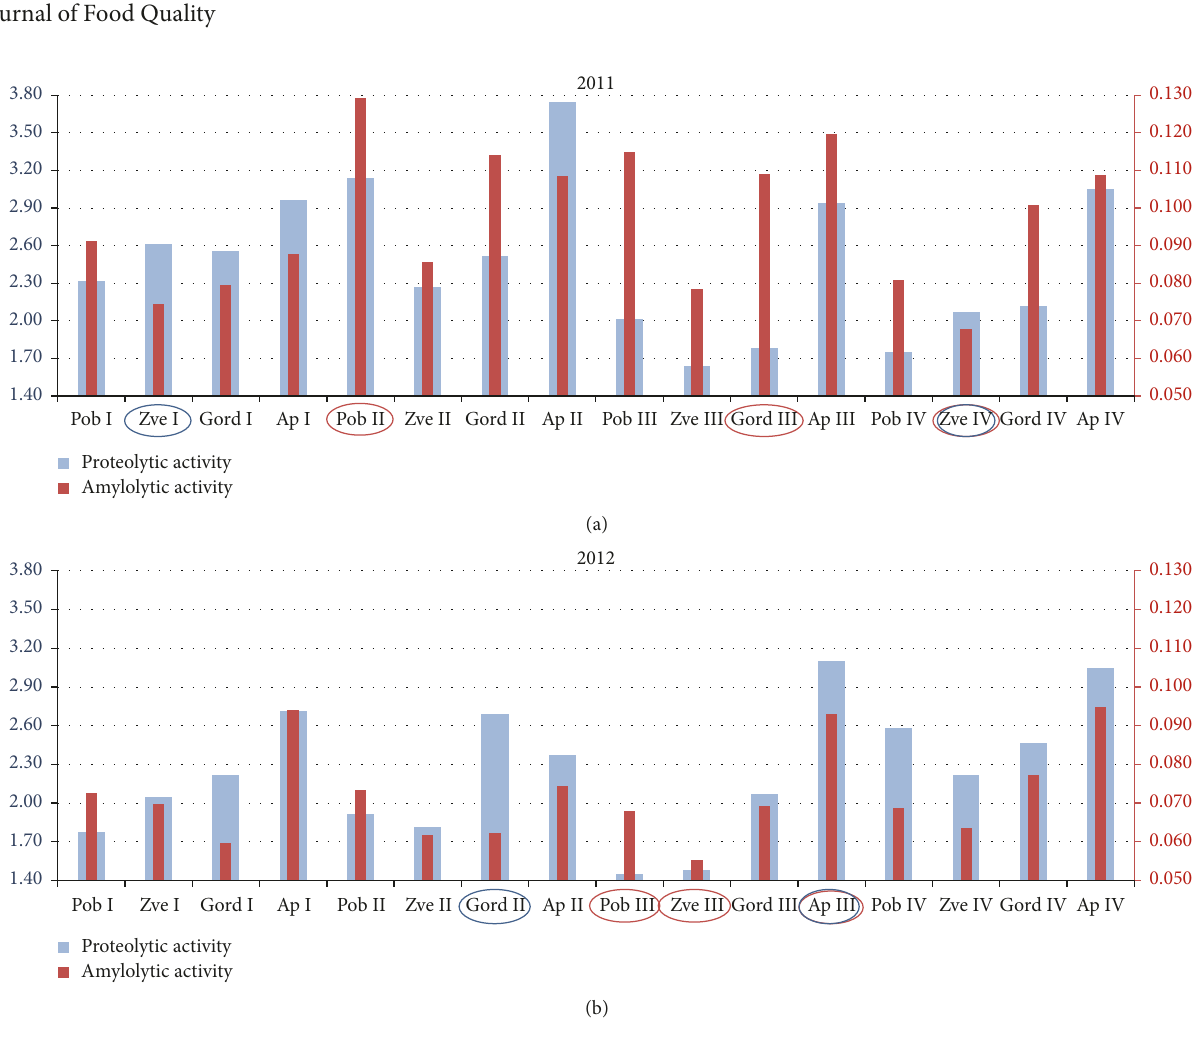
Figure 3: Selected samples from 2011 production year (a) and 2012 production year (b) on the basis of different levels of proteolytic and 𝛼 -amylolytic activity.